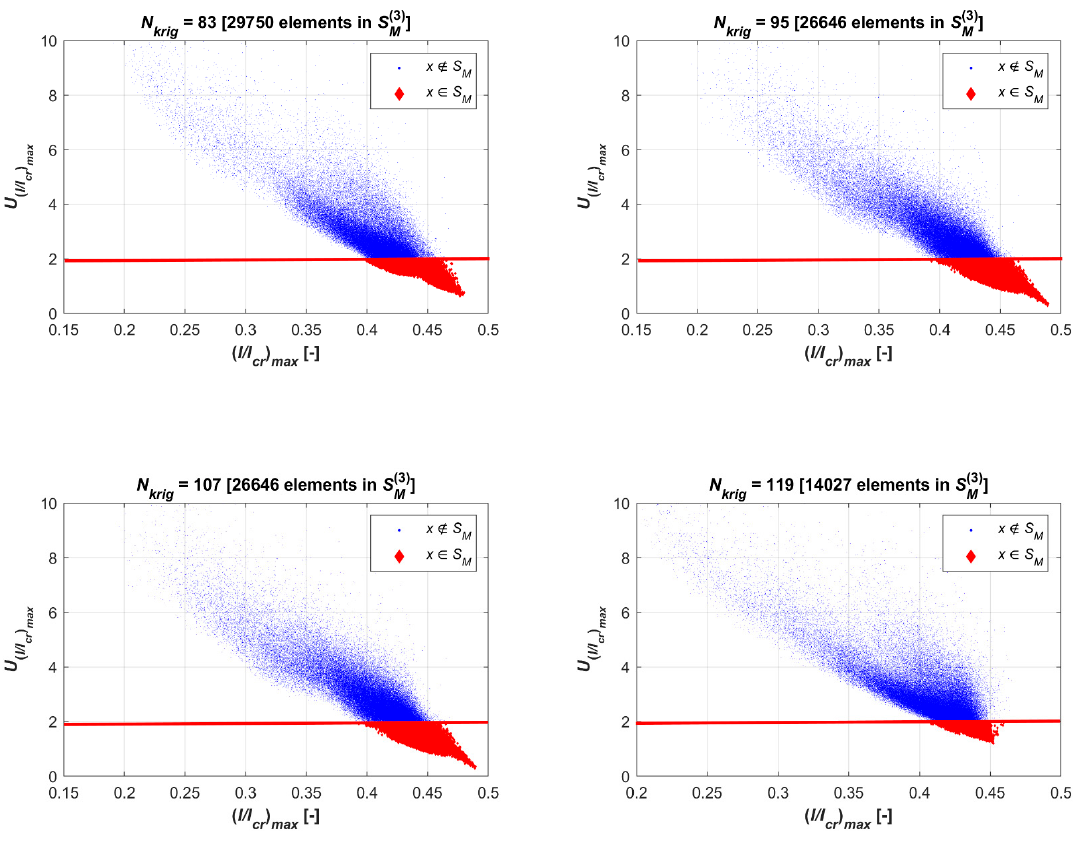
Figure 9. AK-MCS iterations for (cid:3435)(cid:1877) (cid:3036)(cid:2871) ((cid:1872)) (cid:3439)